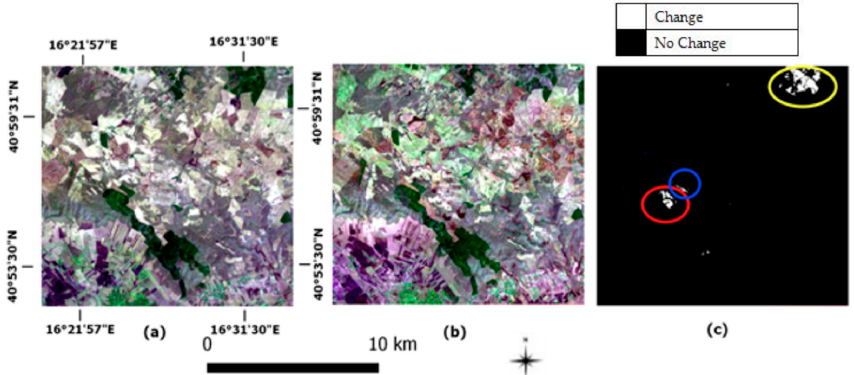
Figure 3. Experiment 1—DIFF_NDVI_HR: Italian site: ( a ) Landsat 7 ETM image, 27 July 2006, RGB: Red–Nir–Blue (T 1 ); ( b ) Landsat 8 OLI image, 7 August 2013, RGB: Red–Nir–Blue (T 2 ); and ( c ) change Map.